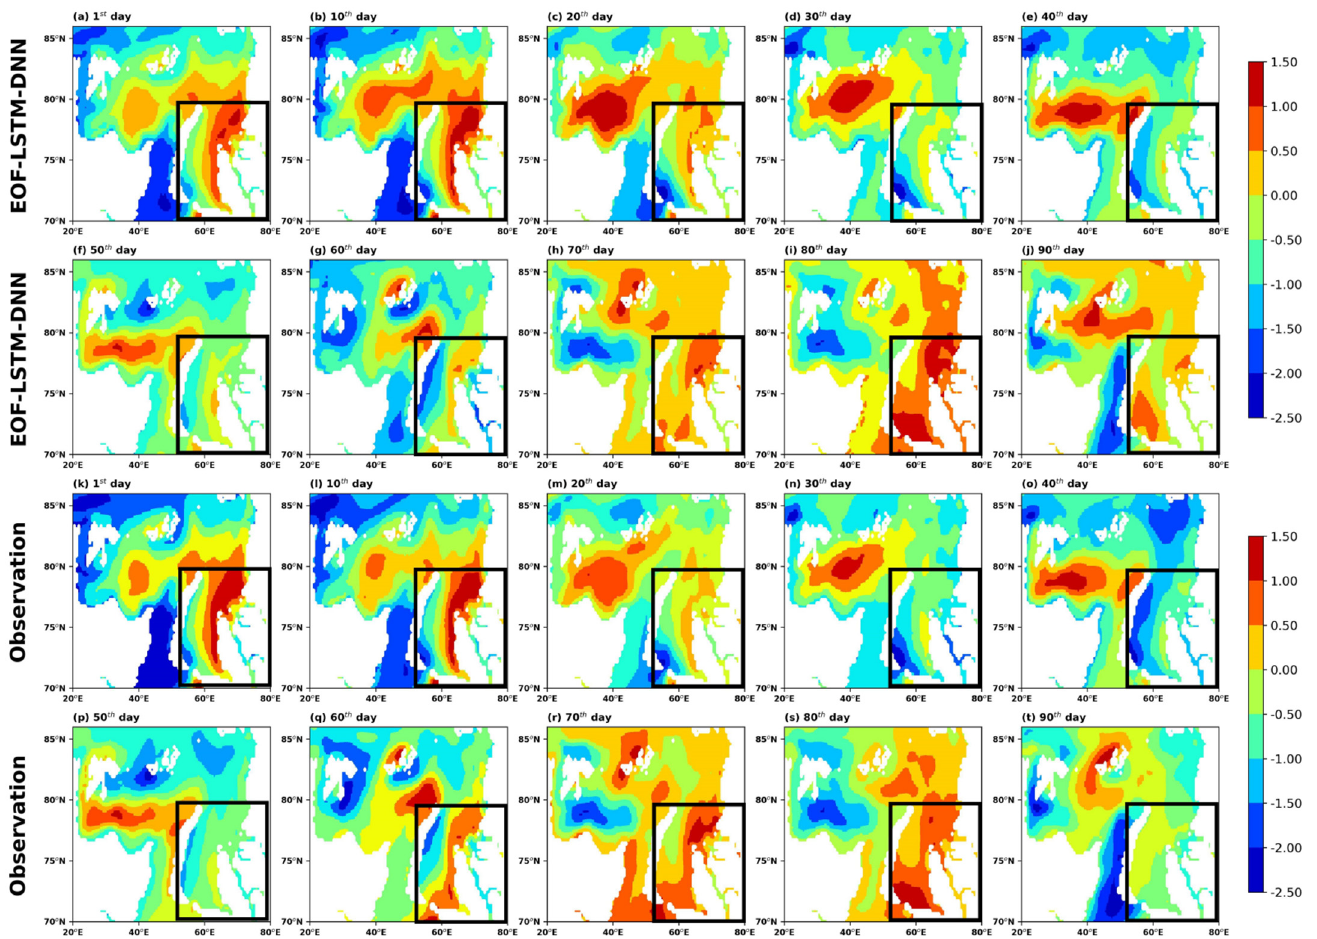
Figure 9. Comparison of the SIC spatial field forecast results ( a – j ) of the ELD model with satellite remote sensing observational data ( k – t ), selected for 100 days in 2019 from 1 January to 10 April.